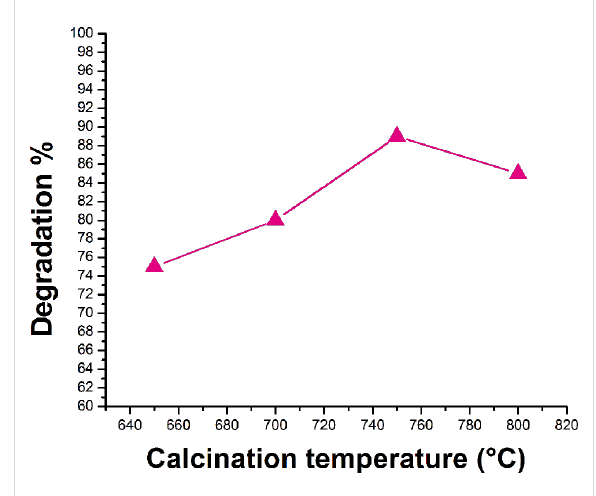
to agglomeration at higher temperature, which ultimately reduces the rate of degradation of rhodamine B [32]. At higher temperature the catalyst is deactivated due to sintering processes that result in a low surface area and smaller number of active sites [33].